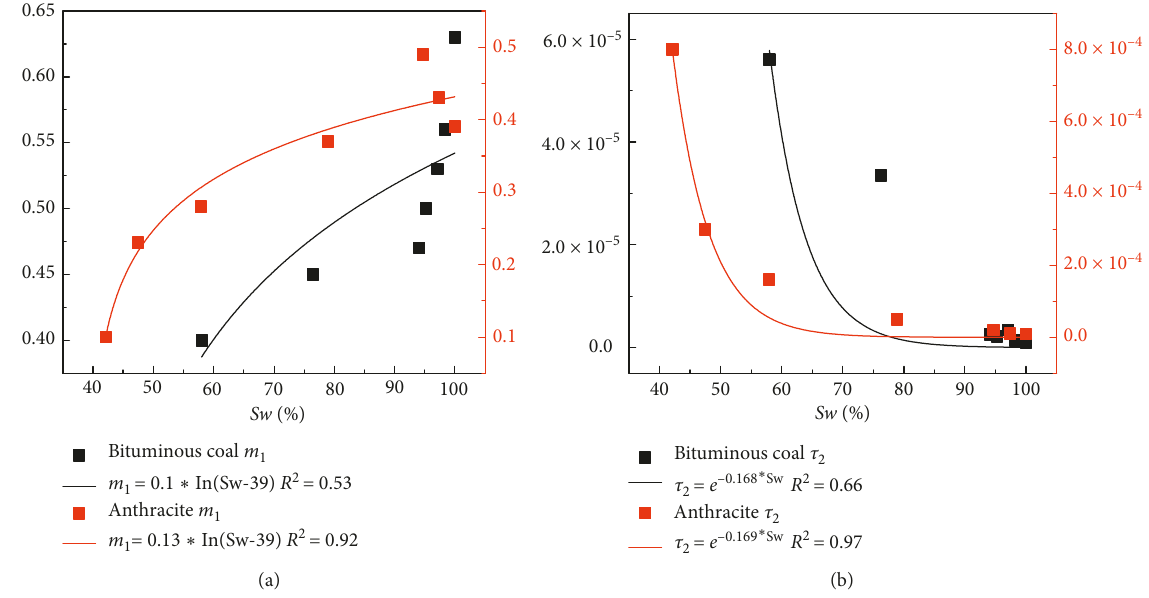
Figure 7: Fitting curves of parameters of the double Cole-Cole model and Sw: (a) the logarithmic function fitting curve of m exponential function fitting curve of τ 2 and